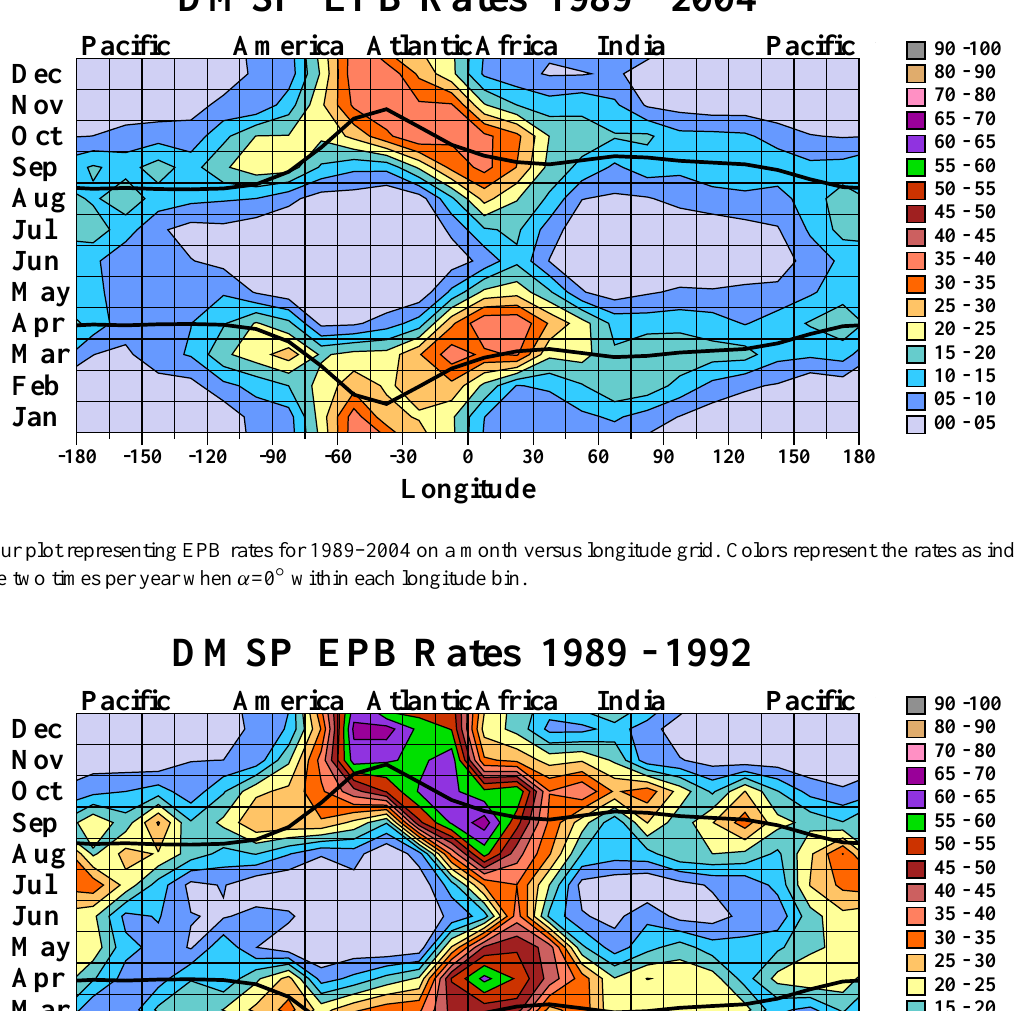
Figure 3 is a rate of occurrence map for EPBs observed by DMSP satellites from 1989–2004 plotted on a month-versus- longitude grid. Longitude ranges from –180 ◦ to 180 ◦ in 24 bins of 15 ◦ . Colors represent rates as indicated. Superim- posed black lines mark the days when α =0 ◦